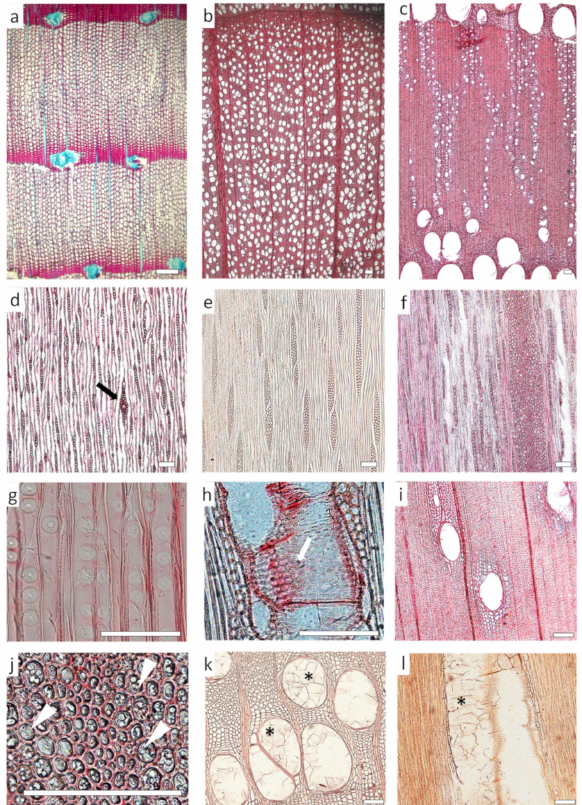
Figure 8. Wood anatomical features related to species’ natural durability. ( a – f ) Differences in conduit diameter and density, proportion of parenchyma and presence of secretory canals between gymnosperms and angiosperms. ( a ) Cross-section of Pinus pinaster ; xylem is formed mainly by tracheids, with parenchyma in uniseriate rays and axial resin canals in blue. ( b ) Cross-section of Fagus sylvatica , a diffuse-porous species, with vessels grouped radially and multiseriate rays. ( c ) Cross section of Quercus pyrenaica , a ring-porous species with uniseriate and wide multiseriate rays and abundant axial parenchyma. ( d ) Tangential section of Pinus pinaster ; black arrow points to